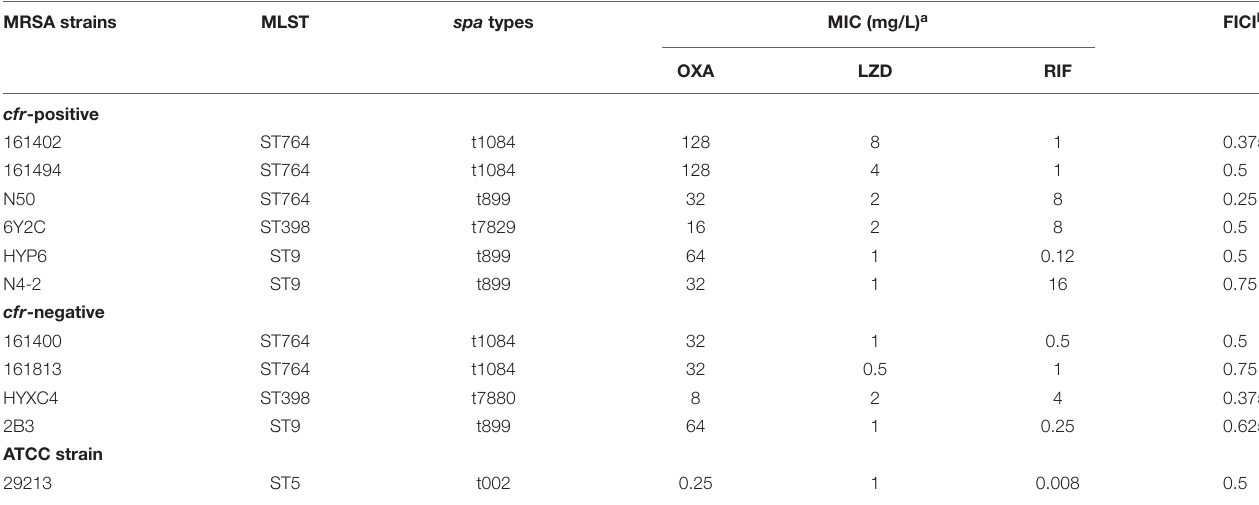
TABLE 1 | Genotypic summary and MICs for study MRSA